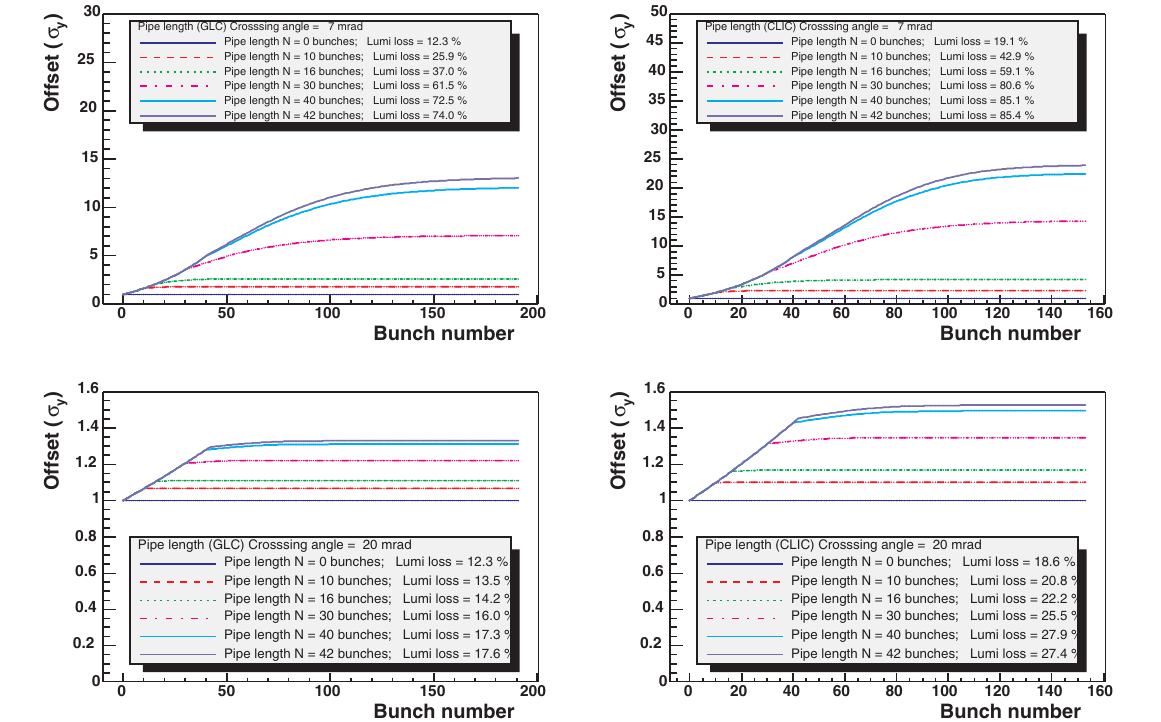
FIG. 5. (Color) Beam blowup as a function of the number of outgoing bunches seen by an incoming bunch for an initial beam offset of for a crossing angle of 7 mrad (upper plots) and 20 mrad (lower plots). 1 (cid:1) y